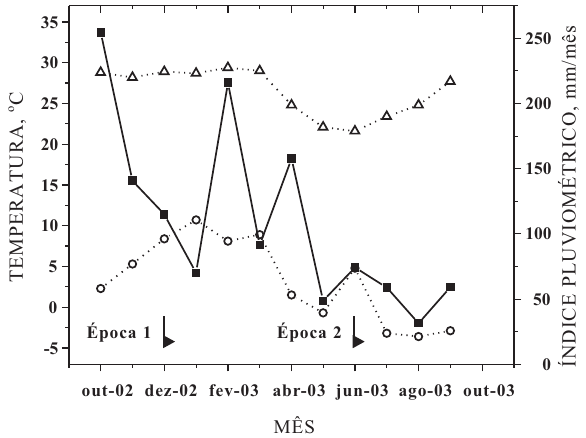
Figura 1. Temperatura máxima ( ΔΔΔΔΔ ), mínima (o) e índice pluviométrico mensal ( ) registrados na localidade de Cedro, município de Urupema-SC, no período de outubro de 2002 a setembro de 2003. As setas indicam os meses de coleta das amostras de